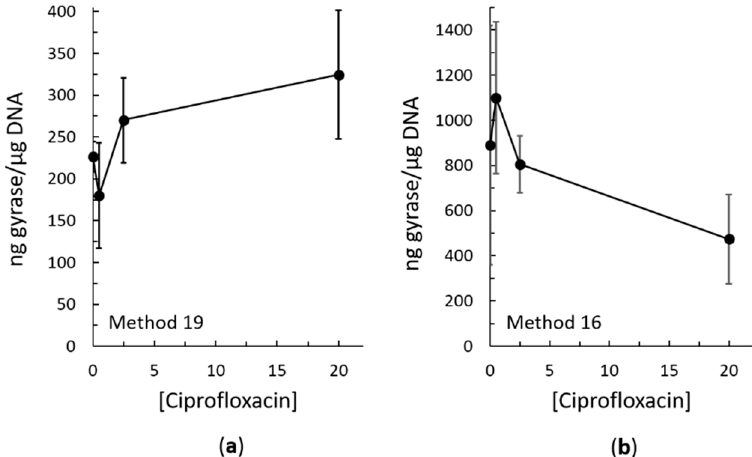
Figure 4. Representative immunoblots of ciprofloxacin-induced type II topoisomerase cleavage complexes trapped in S. aureus using either method 16 or method 19 as indicated at the left. ( a ) Immunoblot of ciprofloxacin-induced gyrase cleavage complexes. Purified S. aureus gyrase subunit A (1, 20, and 80 ng) was also blotted. ( b ) Immunoblot of ciprofloxacin-induced topoisomerase IV cleavage complexes. Purified S. aureus topoisomerase IV subunit A (2.5, 10, and 40 ng) was also blotted. For both ( a , b ), ciprofloxacin concentrations present in each sample are indicated at the top. A total of 100 ng of DNA was blotted in each case.